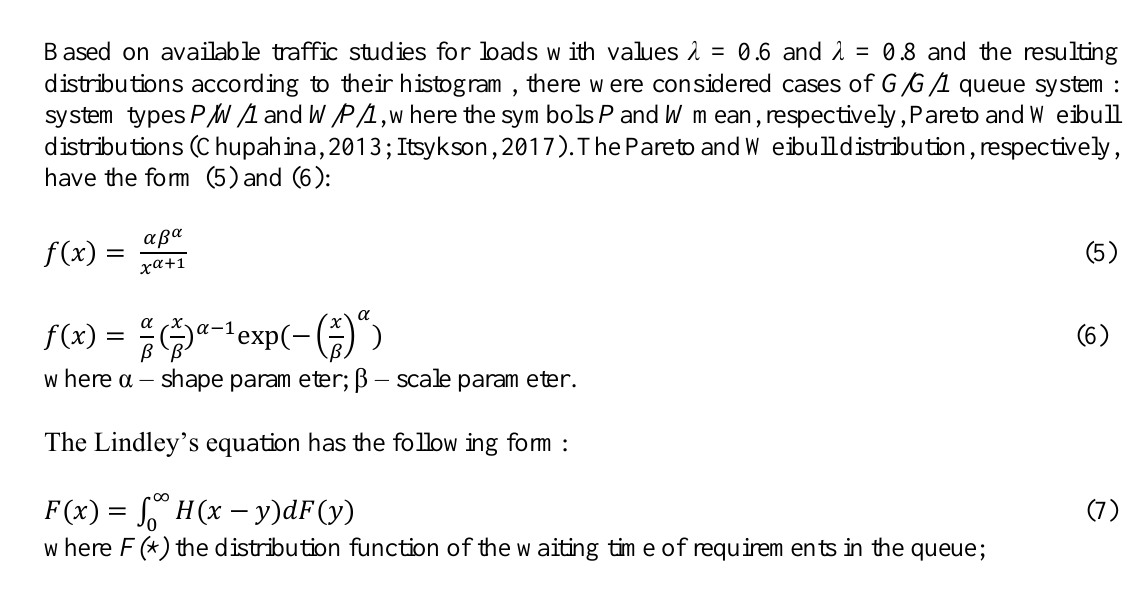
Figure 3. Traffic intensity (packet / sec) at λ =